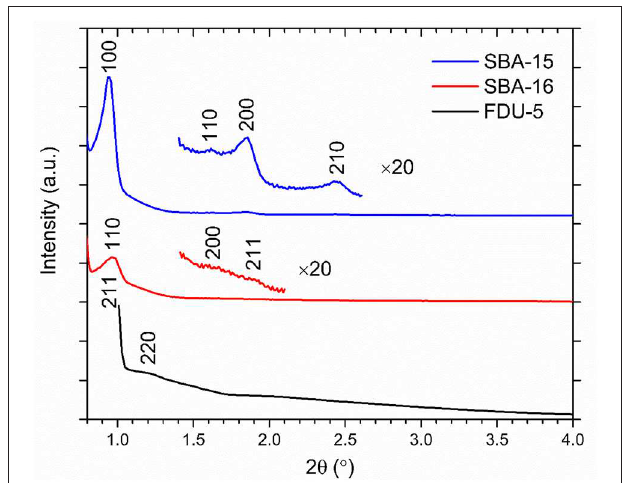
FIGURE 1 | X-ray diffraction patterns of mesoporous silica SBA-15, SBA-16, and FDU-5.